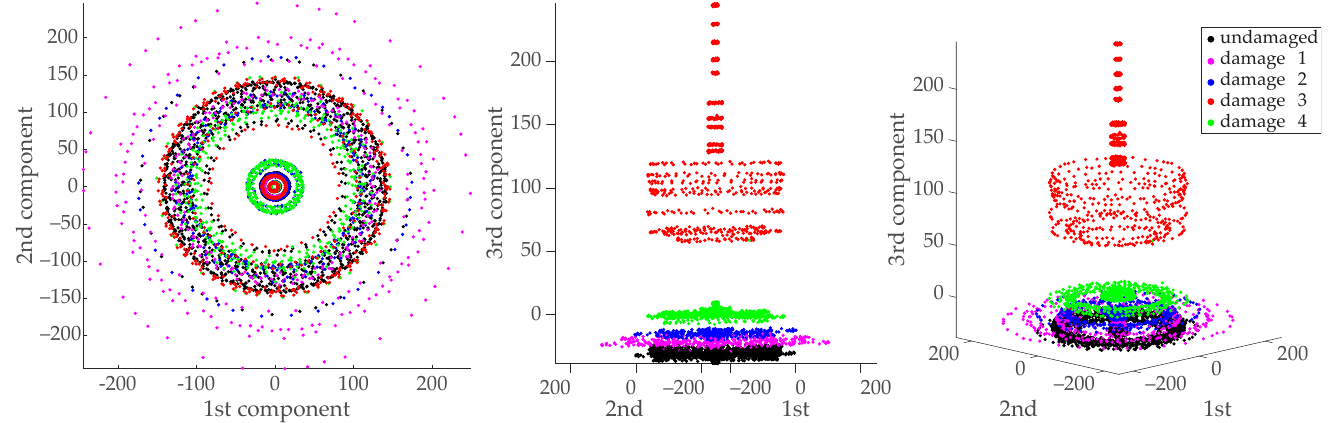
Figure 11. Projection onto the first three principal components of the data in matrix X : first two principal components ( left ), third principal component ( middle ), and three-dimensional view ( right ) of the first three principal components.